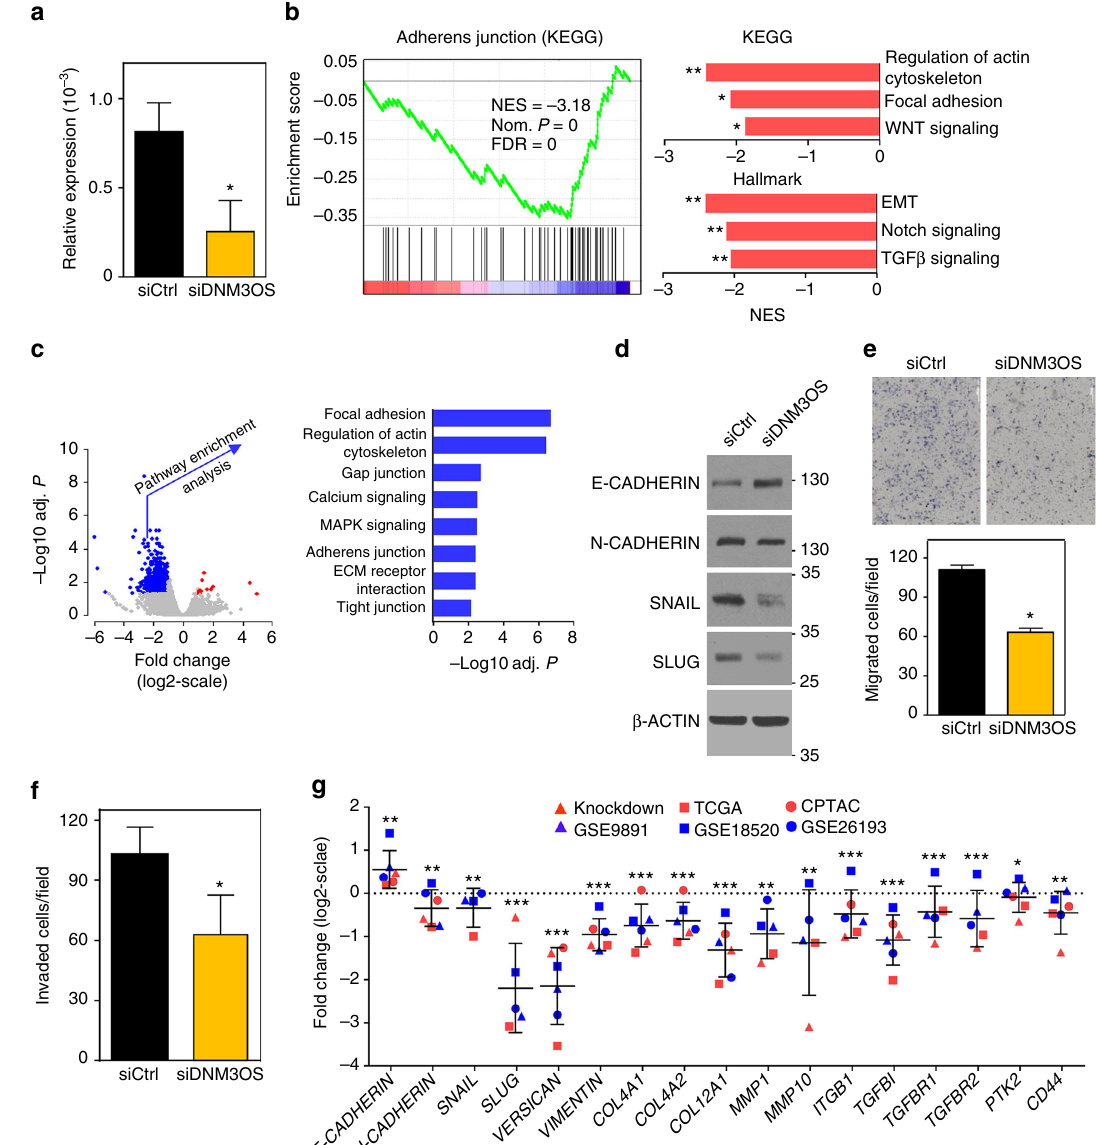
Fig. 6 Reduced expression of DNM3OS favors mesenchymal-to-epithelial transition by deregulating critical genes/pathways. SMARTpool siRNA-speci fi c DNM3OS or non-targeting (NT) control were transfected into SKOV3 cells. a qRT-PCR was performed. Values are relative to β -ACTIN and the mean of 3 experiments; * P = 0.039; one-tailed t -test. b , c RNA sequencing was performed (triplicates). GSEA on pooled samples considering curated data from KEGG and Hallmark data set b ; normalized enrichment score (NES), nominal (Nom.) P- value, false discovery rate (FDR). ** P < 0.006 and * P < 0.05; FDR. All nominal P < 0.006. Volcano plot (left) showing at least twofold up- (red dots) or downregulated (blue dots) genes in DNM3OS knockdown cells compared with non-targeting siRNA controls c . Gray dots represent genes that have lower than twofold expression change. Pathway enrichment analysis of signi fi cantly downregulated genes identi fi ed several EMT-associated pathways as deregulated in DNM3OS knockdown cells; P -values determined by BH adjusted hypergeometric test. d – f Western blot analysis d , transwell migration assay e ; * P = 0.0002 (two tailed t -test), and transwell invasion assay f ; * P = 0.0028 (two tailed t -test) were performed (all representative of at least three independent experiments). In d , representative pictures (4×) shown (white bar represents 300 μ m). g Meta-analysis of six independent ovarian cancer data sets depicts expression changes of EMT-associated genes due to the reduced expression of DNM3OS ; * P ≤ 0.01, ** P ≤ 1.75 × 10 − 04 , *** P ≤ 1.43 × 10 − 12 ; Fisher ’ s combined probability test. For a , e , f , and g error bars are ± indicates the association strength between lncRNA k and gene i . Regression P -values were adjusted using : multiple test correction method (FDR) and signi fi cantly associated lncRNA and mRNA pairs were selected after applying the strict criteria of regression coef fi cient cutoff ± 0.3 and BH adjusted P < 10 − 6 . Genome-wide MEG3 binding sites inferred by ChOP-Seq . We obtained genome- wide mapping of MEG3 binding sites determined by a modi fi ed chromatin oligo af fi nity precipitation (ChOP) method from the author 30 . As explained in the ori- ginal study, we identi fi ed genes having MEG3 bound genomic regions using the tool GREAT 52 .